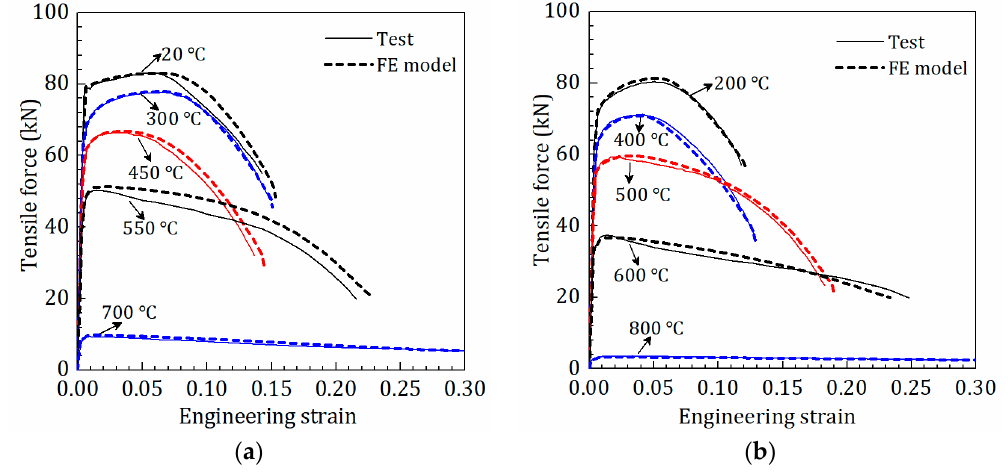
Figure 8. Verification of the proposed constitutive model: ( a ) 20, 300, 450, 550, and 700 ◦ C; ( b ) 200, 400, 500, 600, and 800 ◦